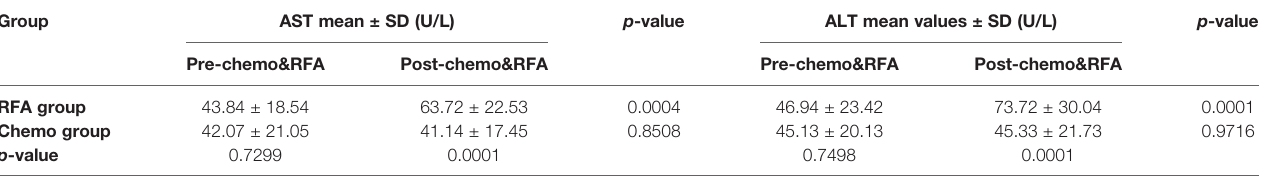
TABLE 4 | Serum AST and ALT levels for all patients.